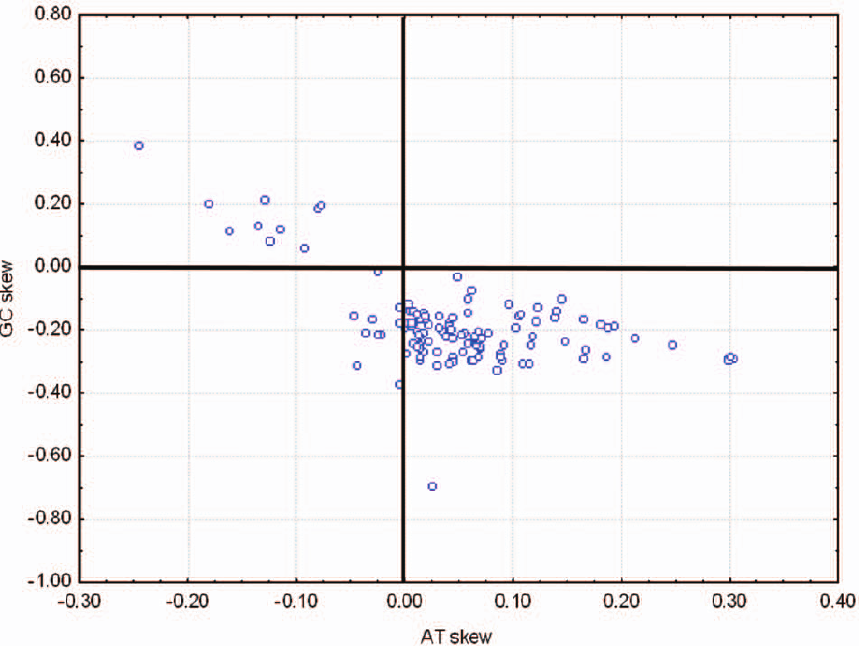
Figure 1. Scatterplots of skews values calculated for whole majority strand of 120 insect mitochondrial genomes. Reversal of both AT and GC skew are found in all species with a sequenced mitochondrial genome of in the families Philopteridae ( Bothriometopus macrocnemis, Campanulotes bidentatus ), Aleyrodidae ( Aleurochiton aceris , Aleurodicus dugesii , Bemisia tabaci , Neomaskellia andropogonis , Tetraleurodes acaciae , Trialeurodes vaporariorum ) and Braconidae ( Cotesia vestalis , Spathius agrili ). Reversal of AT skew was found in 10 unrelated species: Onychiurus orientalis (Collembola: Onychiuridae), Bilobella aurantiaca (Collembola: Neanuridae), Heterodoxus macropus (Phthiraptera: Boopidae), Antheraea pernyi (Lepidoptera: Saturniidae), Coreana raphaelis (Lepidoptera: Lycaenidae), Manduca sexta (Lepidoptera: Sphingidae), Saturnia boisduvalii (Lepidoptera: Saturniidae), Simosyrphus grandicornis (Diptera: Syrphidae), Polystoechotes punctatus (Neuroptera: Polystoechotidae) and Abispa ephippium (Hymenoptera: